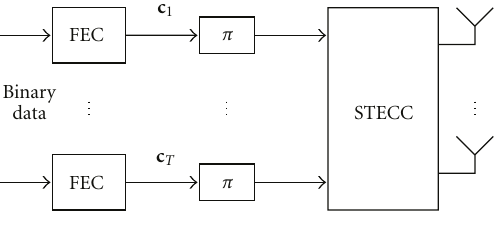
Figure 1: Concatenated STECC transmitter scheme.